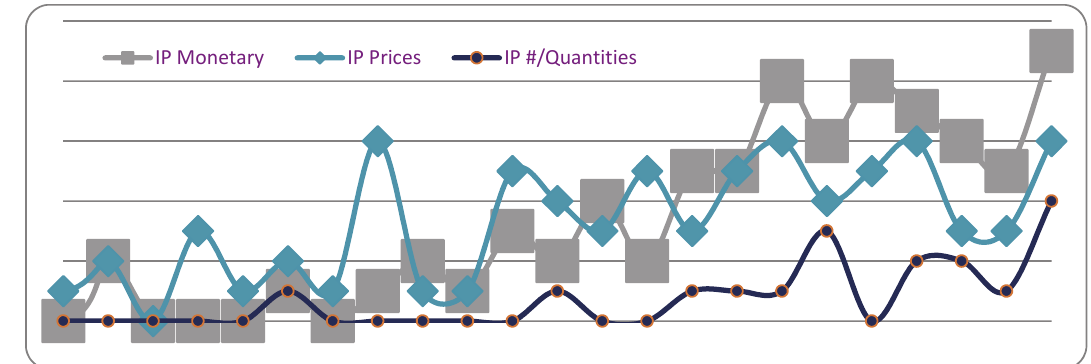
Fig. 11. Number of Life Insurance Efficiency Studies Using Different Input Proxy Forms